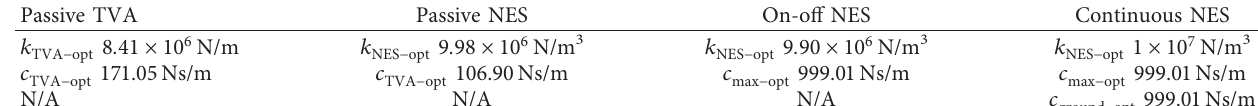
Table 3: Summary of optimal parameters obtained with the periodic cutting force. Passive TVA Passive NES On-off NES Continuous